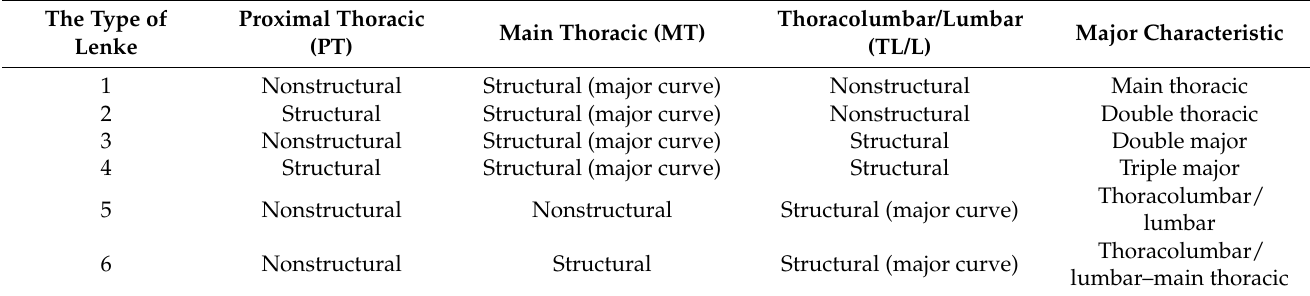
Table 1. The criteria for determining the type of Lenke